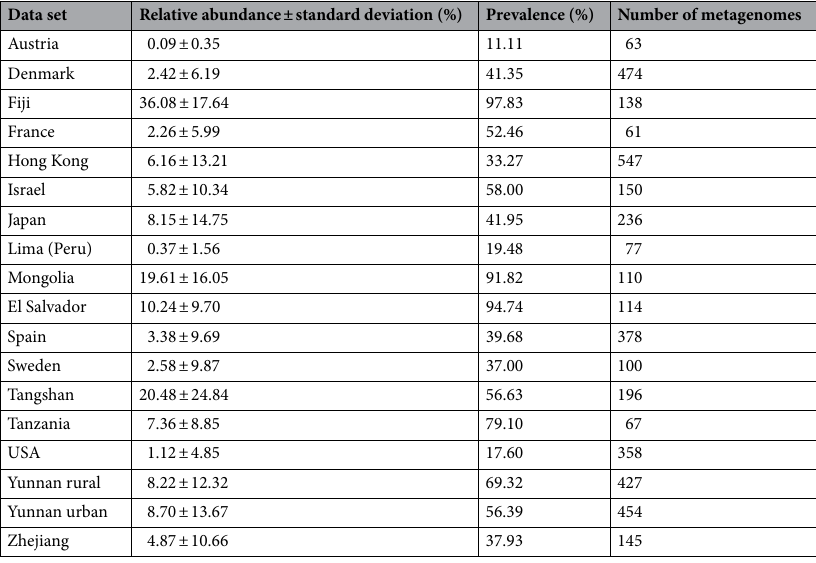
Table 1. Distribution of total Prevotella in the human gut.